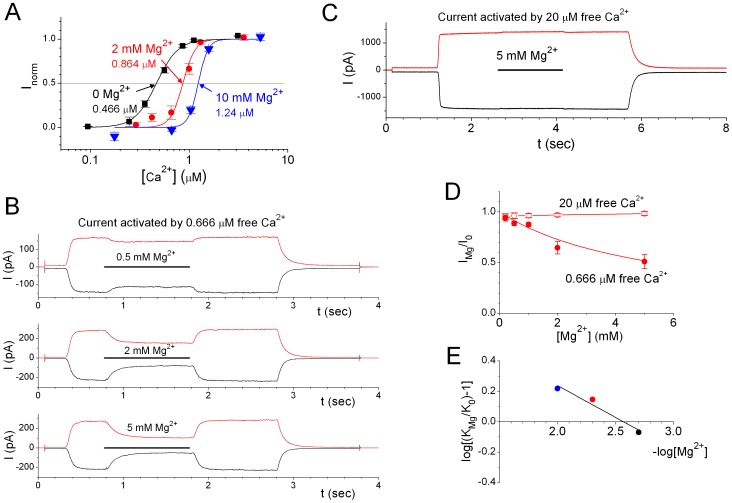
Mg2+ shifts the Ca2+-activation curve of ANO1.(A) Dose-response curves of ANO1 activation by Ca2+ in the absence (black) or in the presence of 2 mM (red; N = 4) and 10 mM (blue; N = 6) intracellular Mg2+. The values of K1/2,Ca in each condition are shown. (B) Mg2+ inhibits ANO1 current induced by non-saturating [Ca2+] in a dose-dependent manner. (C) ANO1 current activated by saturating [Ca2+] was not inhibited by 5 mM Mg2+. (D) Comparison of the dose-dependent Mg2+ inhibitions of ANO1 currents induced by 0.666 µM and 20 µM free Ca2+. Data were obtained from experiments like those shown in B in 3 (0.666 µM) and 5 patches (20 µM). Data points of 20 µM Ca2+ are connected by straight line segments while those of 0.666 uM Ca2+ are fitted to eq. 2 with an apparent half-inhibition concentration of 5.4 mM. (E) Schild plot of the K1/2′s of the Ca2+-activation curve of ANO1 in the absence and presence of Mg2+. K1/2′s of the Ca2+-activation curves shown in A were determined, and those obtained in 2 (black), 5 (red) and 10 mM (blue) of Mg2+ (KMg) together with that in the absence of Mg2+ (K0) were used to construct the Schild plot. The straight line fitted to the data points crossed the horizontal axis at pMg = ∼2.6, indicating that ∼2.5 mM [Mg2+] reduces the ANO1 affinity for Ca2+ by half.